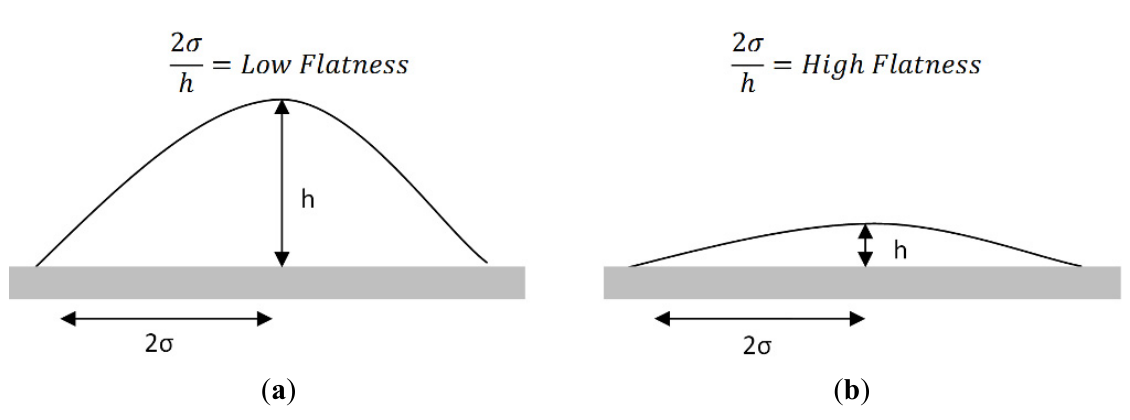
Figure 4. Schematic representing ( a ) low and ( b ) high flatness spray